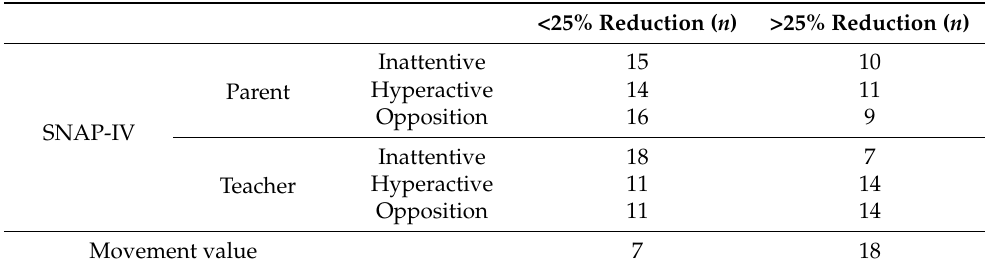
Table 3. Treatment outcome comparison in 25 children with ADHD using SNAP scores and move- ment